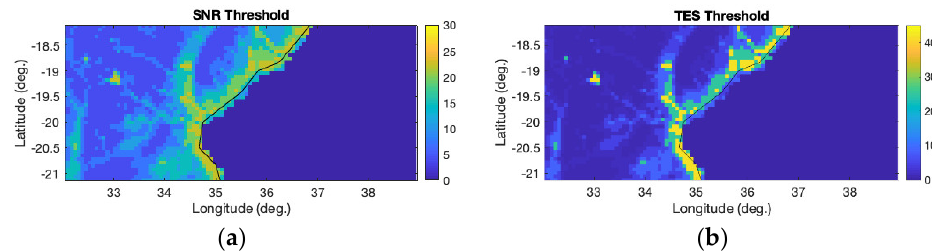
Figure 8. Threshold classification maps obtained for the area under study using 1 year of data for ( a ) SNR observable and ( b ) TES observable.